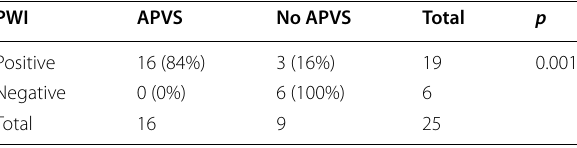
Table 6 Relation between PWI changes and APVS in